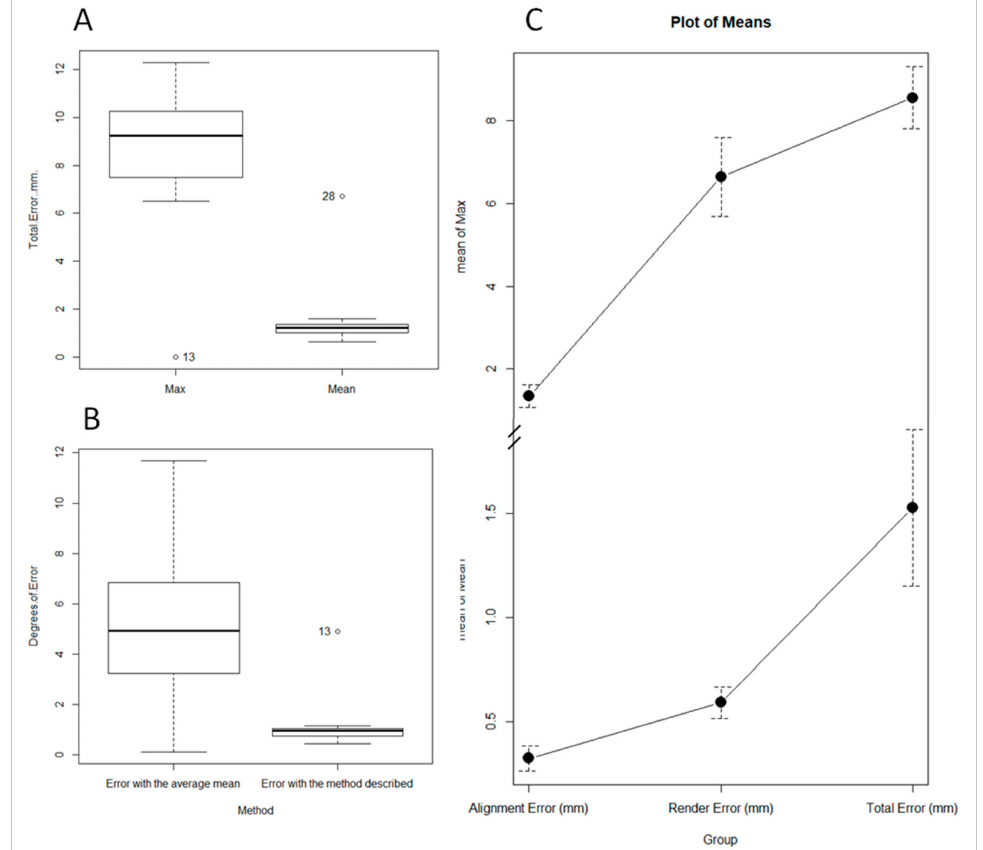
Figure 5. ( A ): Maximum mean error and total mean error between a femur and the mirror image of the contralateral side. These errors include the skewness error, the rendering error, and the alignment error, intrinsic to biomodel processing. ( B ) Interpersonal variability (represented as the mean of the di ff erences in the femoral version of the patients, with respect to the series mean) and intrapersonal variability (represented as the mean of the di ff erences in the femoral version of the patients, with respect to their contralateral side with the described method). ( C ) Representation of the contribution to the total error of the alignment error and the rendering